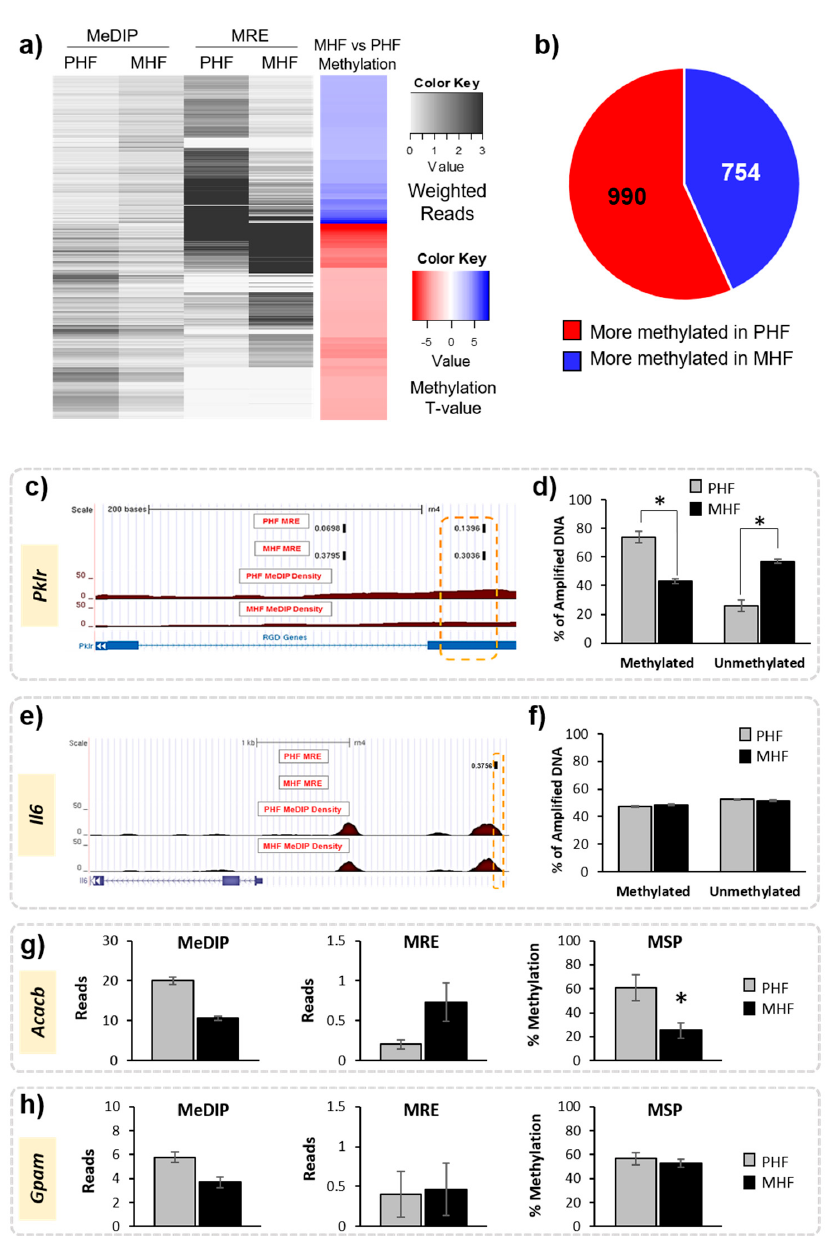
Figure 2. Identification of di ff erentially methylated regions in maternal and post-weaning HF diet groups. ( a ) Heatmap shows the weighted MeDIP and MRE reads in the MHF and PHF